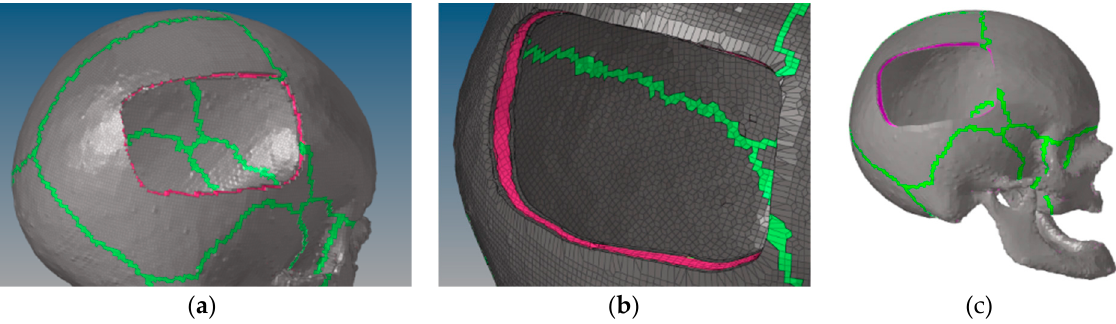
Figure 1. Creation of the skull defect: ( a ) skull after elements were deleted; ( b ) skull after the projection of the border elements; ( c ) final skull model after the deletion of the poor elements on the defect’s border.